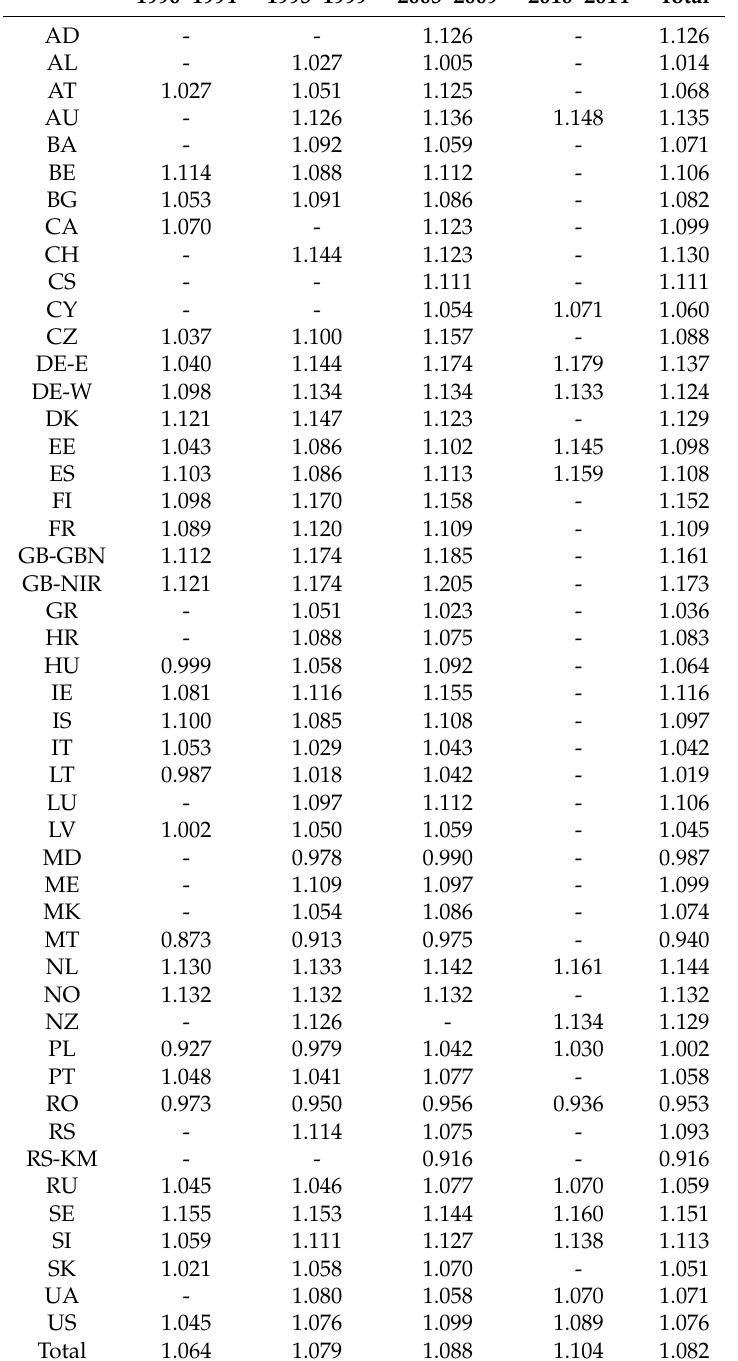
Table A4. The mean of the relative importance of friends by country and